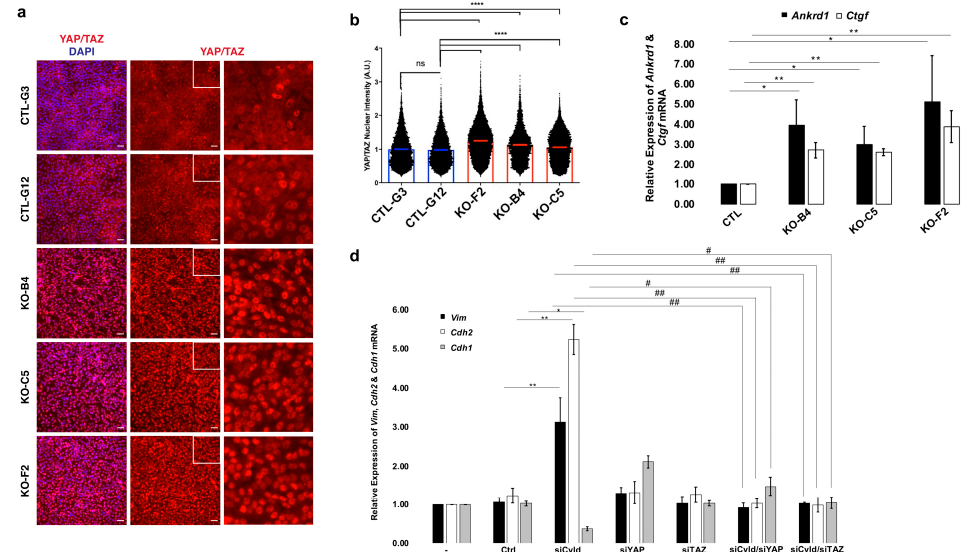
Figure 5. CYLD-regulated mammary EMT depends on the inhibition of the Hippo pathway. ( a ) Immunofluorescence analysis of YAP and TAZ localization in control (CTL-) and CYLD-deficient MCF10A clones (KO-). ( b ) YAP / TAZ staining intensity in individual nuclei was measured relative to the average nuclear area from panel a . Results were normalized to clone CTL-G3 to obtain fold changes in YAP / TAZ levels between clones. Statistical analysis was performed using one-way ANOVA and Tukey’s multiple comparisons tests. CTL-G3 ( n = 7926), CTL-G12 ( n = 6778), KO-F2 ( n = 14360), KO-B4 ( n = 5883), and KO-C5 ( n = 8453). Error bars represent mean +/ − SD. (**** p < 0.0001) ( c ) CYLD inactivation leads to the induction of YAP / TAZ target genes. Total RNA was extracted from control (CTL) and CYLD-deficient MCF10A cells (KO-B4, KO-C5, and KO-F2) and used to determine the relative levels of the indicated ANKRD1 ( Ankrd1 ) and CTGF ( Ctgf ) mRNAs using qPCR. The